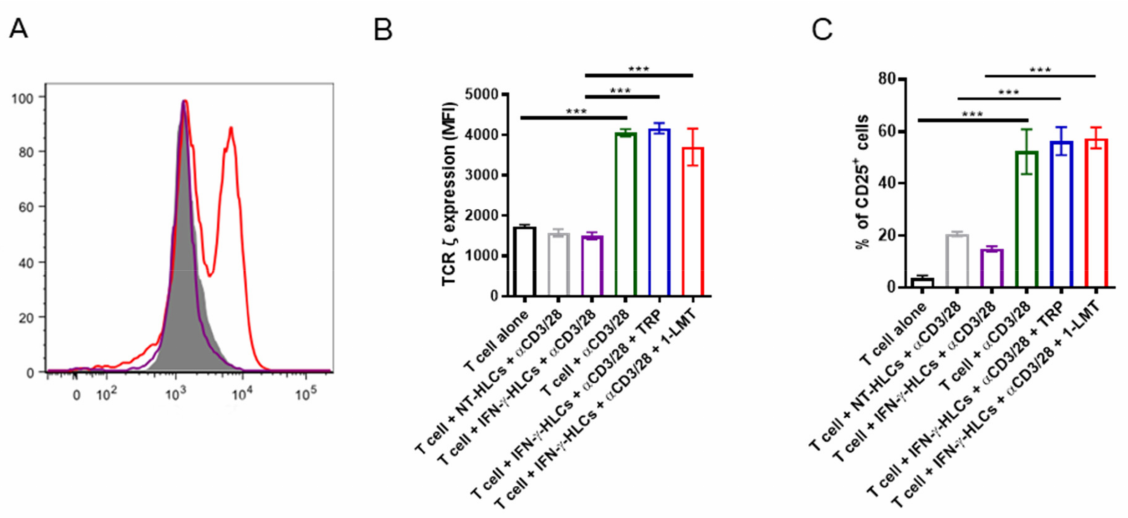
Figure 4. TCR ζ expression in CD4 + T cells. ( A ) Representative histogram for TCR ζ expression in CD4 + T cells co-cultured with IFN- γ -treated HLCs and in the presence (red line) or absence (purple line) of 200 µ M 1-LMT. Isotype control in grey. ( B ) Quantification of TCR ζ expression (MFI) in non-activated (median = 1728 range = 216) and activated (median = 4023 range = 175) CD4 + T cells co-cultured with IFN- γ -treated HLCs (median = 1527 range = 167) in the presence of 200 µ M of 1-LMT (median = 3923 range = 826) or tryptophan (median = 4171 range = 311). ( C ) Percentage of CD25 + cells in non-activated (median = 3.7 range = 1.8) and activated (median = 52 range = 17) CD4 + T cells co-cultured with IFN- γ -treated HLCs (median = 14.7 range = 2.5) in the presence of 200 µ M of 1-LMT (median = 57.2 range = 8.1) or tryptophan (median = 56.65 range = 10.4). *** p < 0.001. One-way ANOVA. Data are expressed as mean ± SD of 3 independent experiments, with one donor per experiment, in